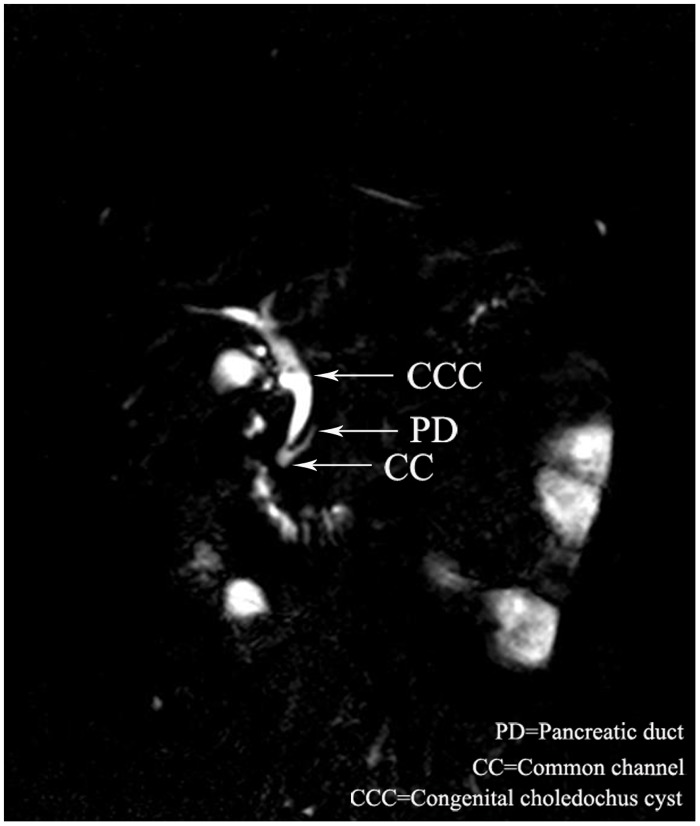
A 9-year old female with PBM, MRCP showed the cylindricality dilataion of the cyst.